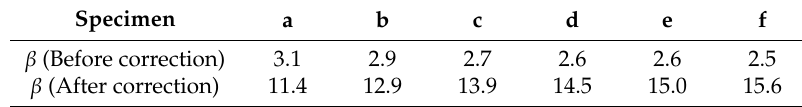
Table 3. Nonlinear parameters for di ff erent specimens before and after